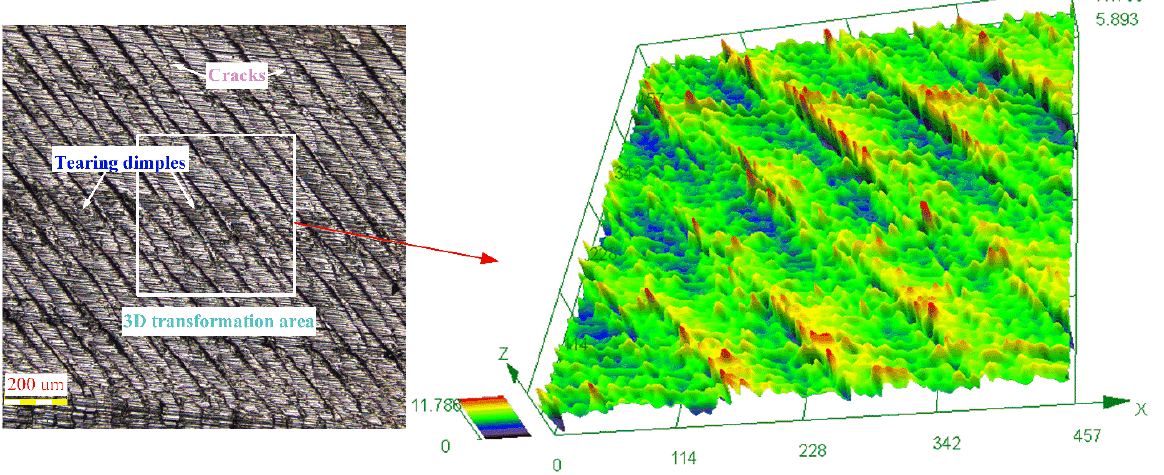
Figure 7. Tearing dimples and cracks.